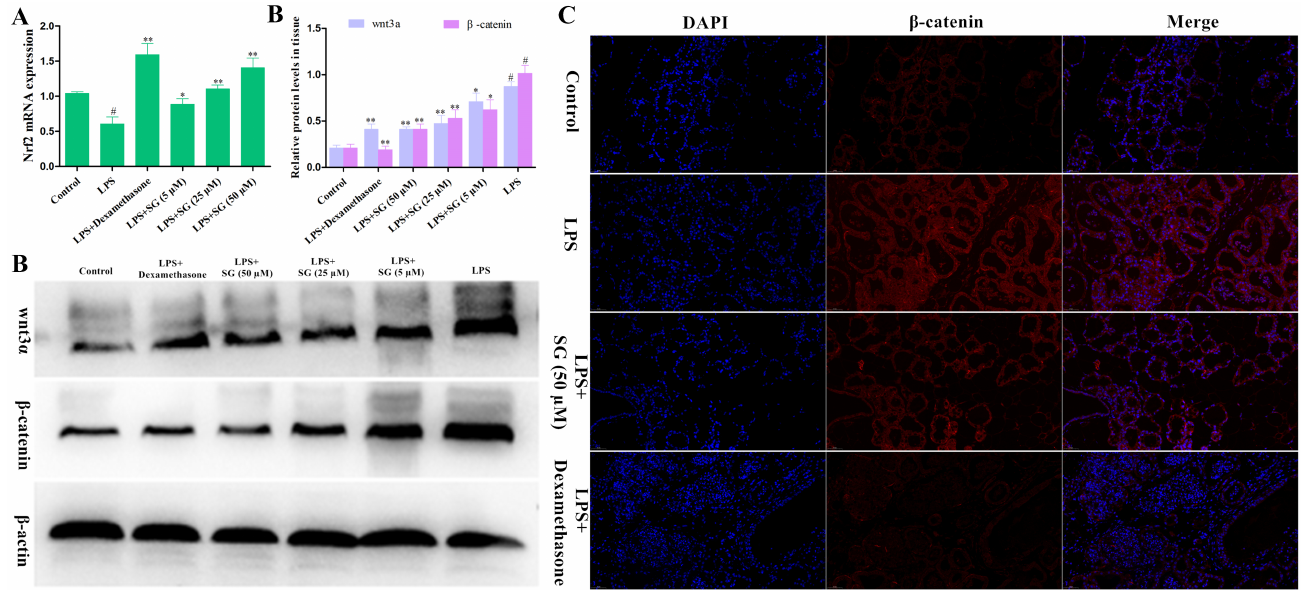
Figure 7. Effects of SG on the activation of Nrf2 and the Wnt/ β -catenin pathway. ( A ) The expression of Nrf2 was determined by qRT-PCR assay. ( B ) The levels of proteins in the Wnt/ β -catenin pathway were detected by Western blot assay. ( C ) The level of β -catenin protein was determined by an im- munofluorescence technique (scale bar: 50 µ m). Statistical analysis of the Western blot quantification should be carried out by performing a multiple t -test. Data are presented as the means ± SEMs of three independent experiments. The symbol # indicates p < 0.05 vs. the control group. The symbols * and ** represent significant differences at p < 0.05 and p < 0.01,